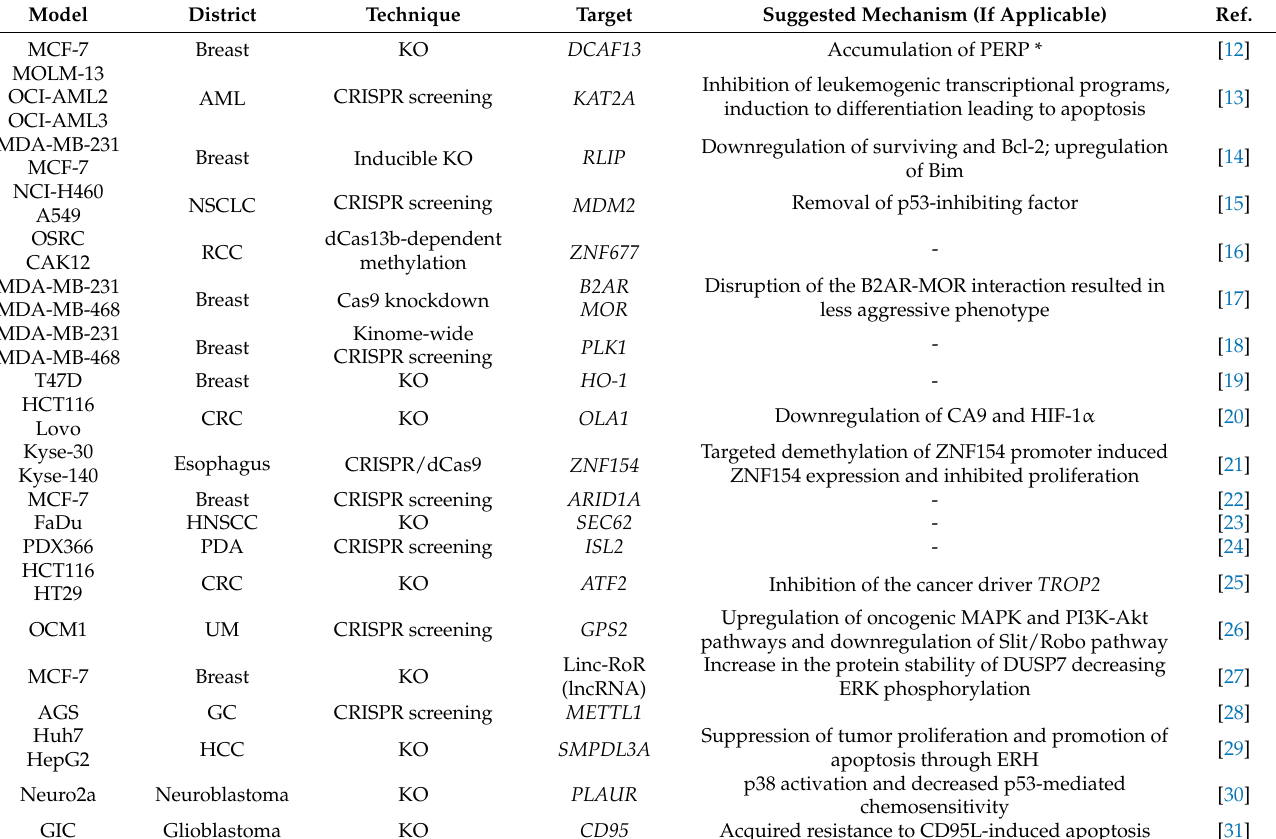
Table 1. CRISPR-targeted genes that impaired cell